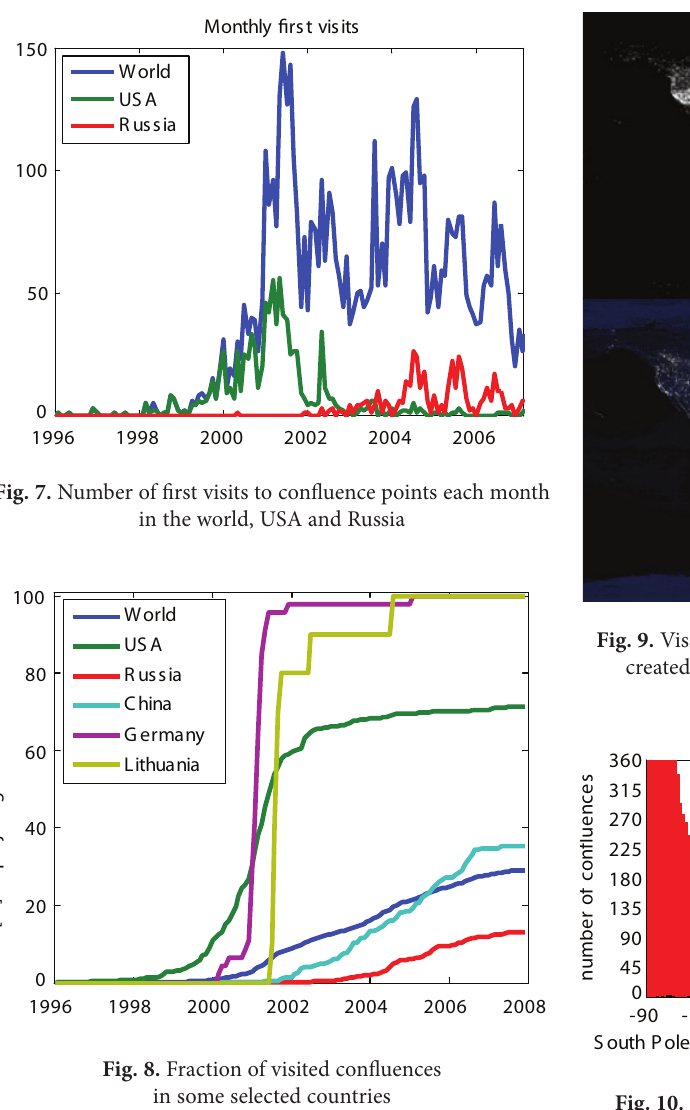
Fig. 10. Land based confluence points by degree latitude. Negative values represent the southern hemisphere. The fraction of visited confluences is drawn in